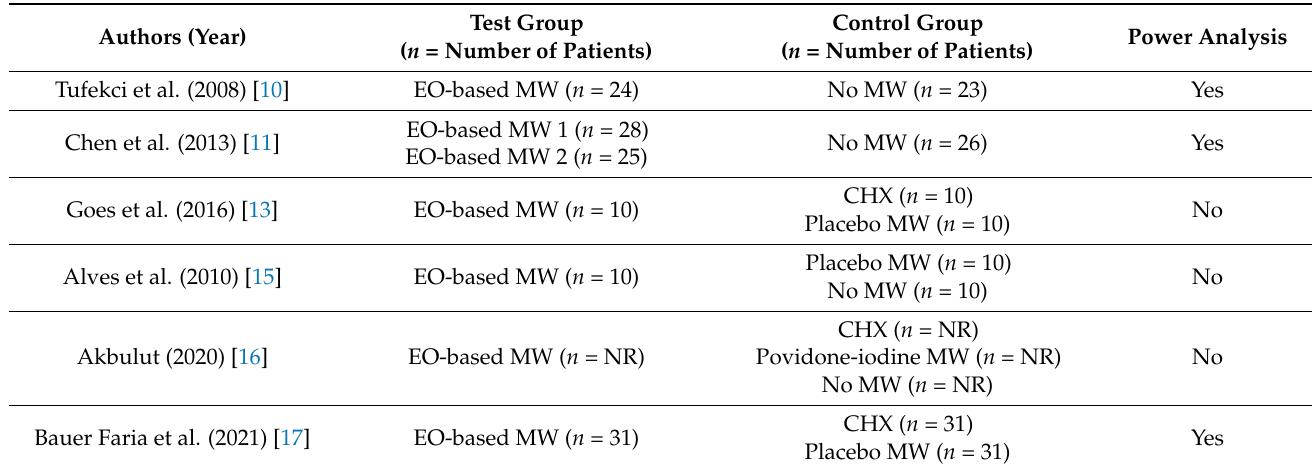
Table 2. Test and control groups and power